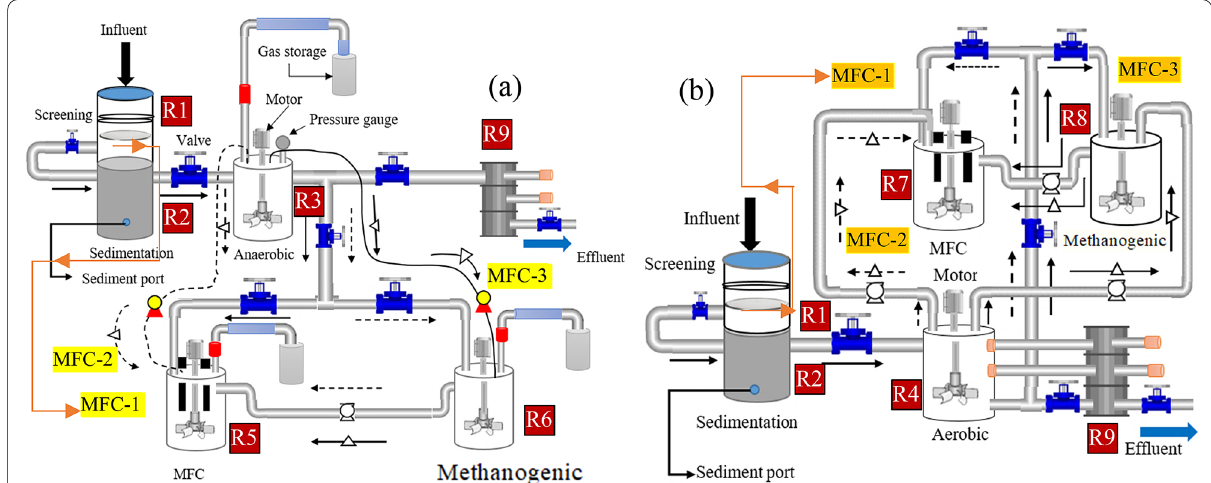
Fig. 4 Operation mechanisms for a anaerobic-MFC and b aerobic-MFC system. Within each system, MFC-1 is considered as a direct-fed MFC (control) or standalone system, whereas the MFC-2 and -3 are integrated systems. The arrows indicate the water flow